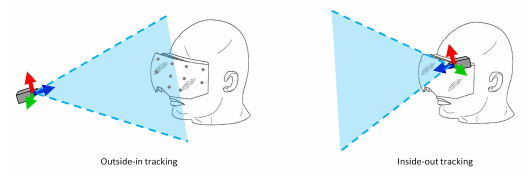
Figure 2: Outside-in vs Inside-out tracking approaches